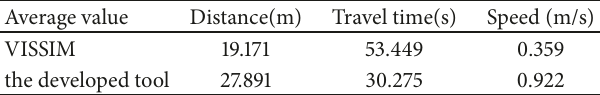
Table 6: Comparison of local route simulation